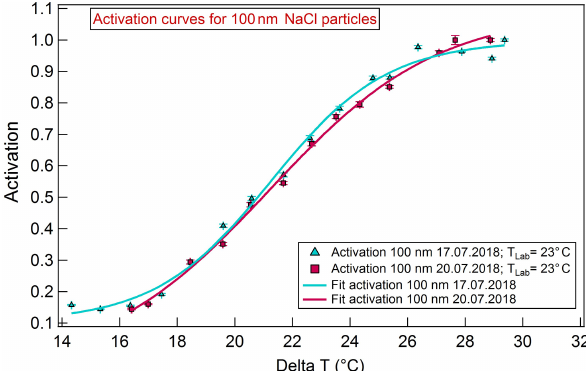
Figure 3. Activation curves for NaCl particles of different sizes at different (cid:49)T , which is the temperature difference between the sat- urator temperature T s and condenser temperature T c . The measured values (points) are fitted with sigmoidal curves.